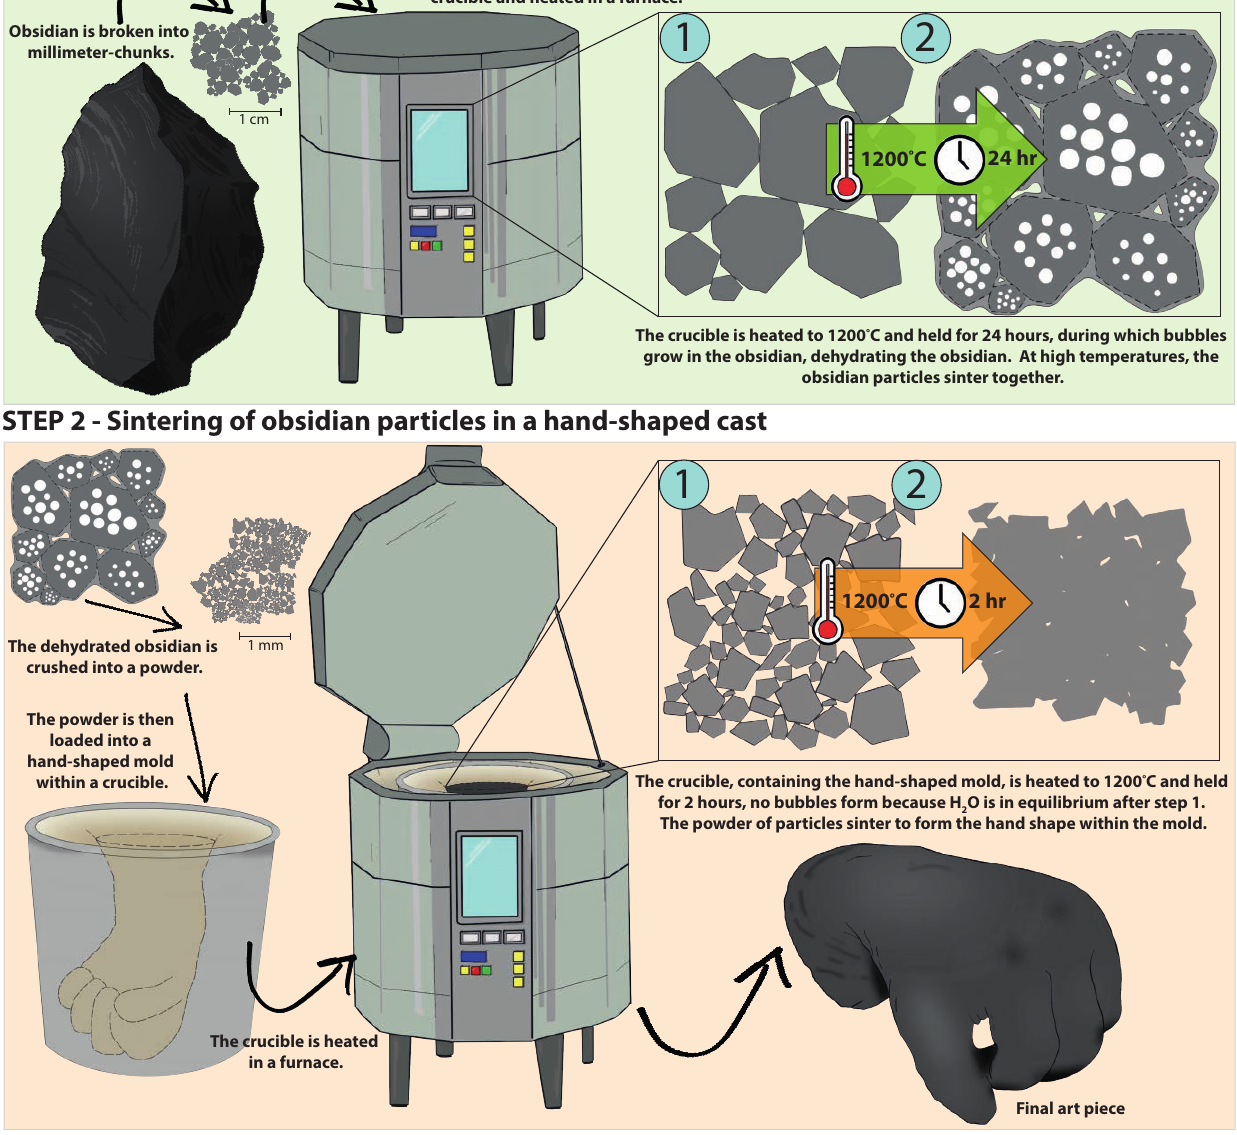
Figure 9: An illustrated workflow for using obsidian in casting, such as in the production of ’PEDM’. Step 1 involves the dehydration of natural obsidian in a pre-processing high-temperature step. Step 2 involves the crushing of the dehydrated obsidian from step 1 in a sinter-casting methodology. See text for